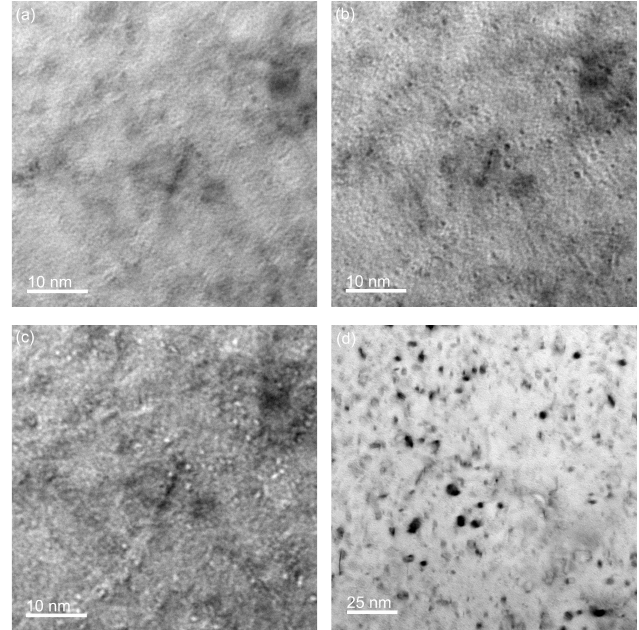
Figure 3. Small helium bubble (2-nm diameter) were observed in the implanted samples using through-focus imaging ( ± 1 µ m). Bubbles are nearly invisible in the ( a ) focused image, but appear dark and light in the ( b ) overfocused and ( c ) underfocused conditions, respectively. Additional displacement related defects (e.g., dislocation loops) were observed, as seen in the ( d ) 4000 appm implanted